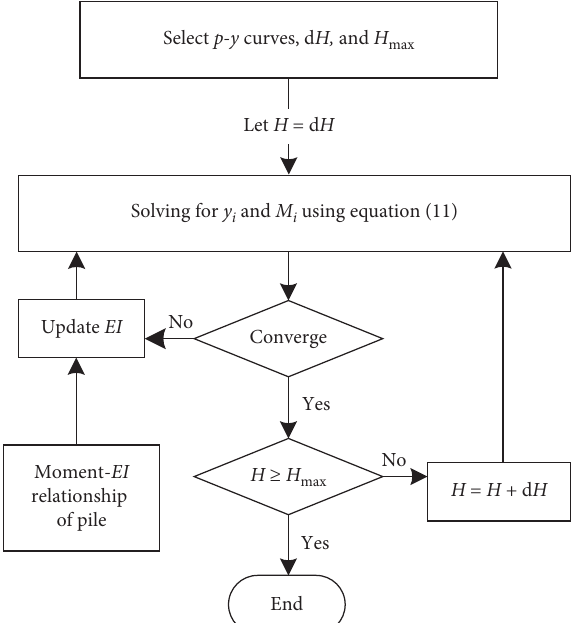
Figure 6: Analysis process of the proposed method.